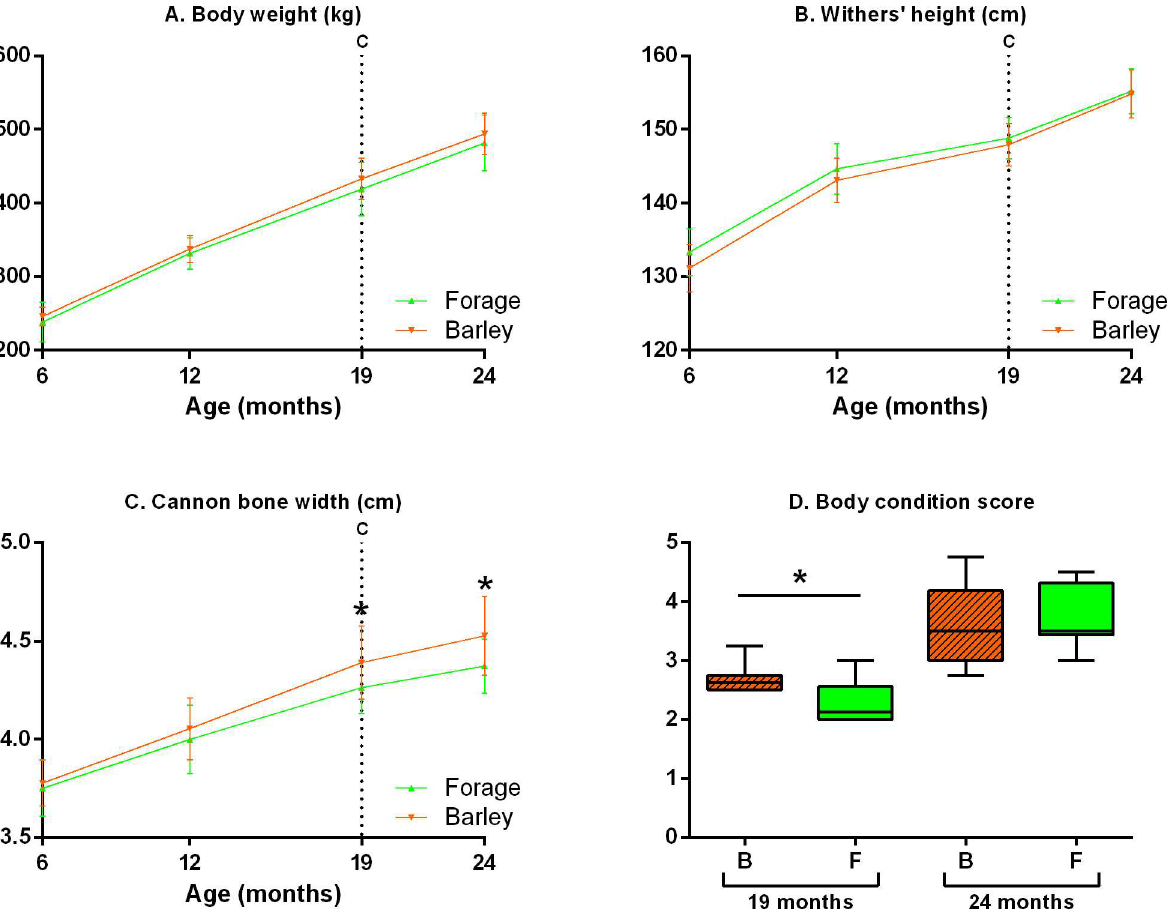
Fig 4. Foals’ and yearlings’ (median and IQR) body weight (A), withers’ height (B) and cannon bone width (C) between 6 and 24 months of age and body condition score (D) at 19 and 24 months of age. B: Foals born to dams fed with barley and forage (n = 12), F: Foals born to dams fed with forage only (n = 12), C: Beginningof the feedingchallenge.Values marked with an asterisk are significantly different (p < 0.05).